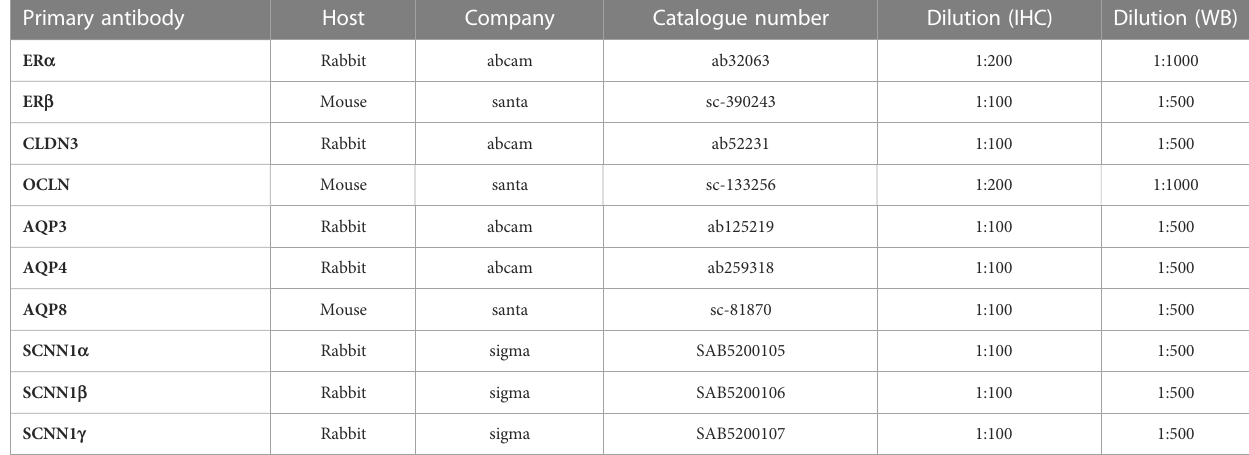
TABLE 1 Primary antibodies